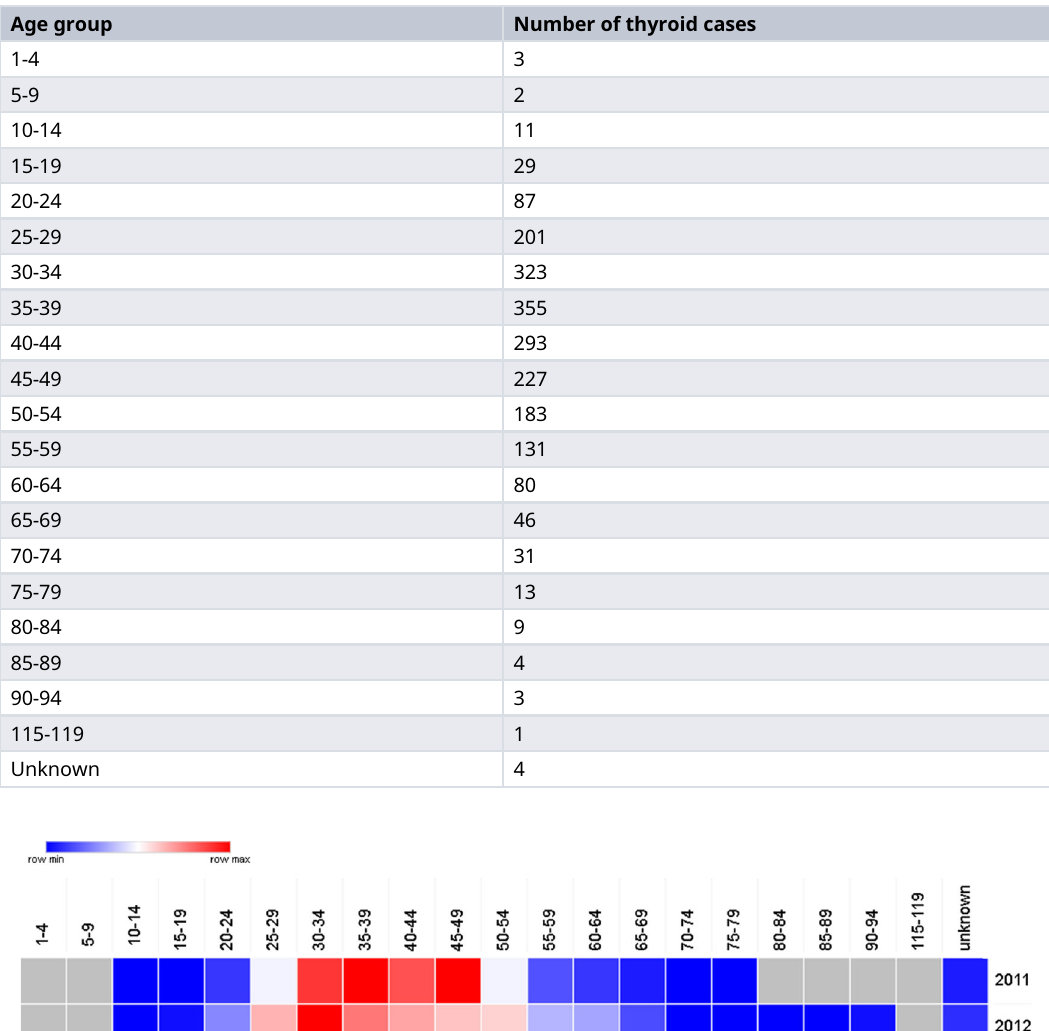
Table 7. Overall age-specified distribution of thyroid cancer in UAE from 2011 to 2017.